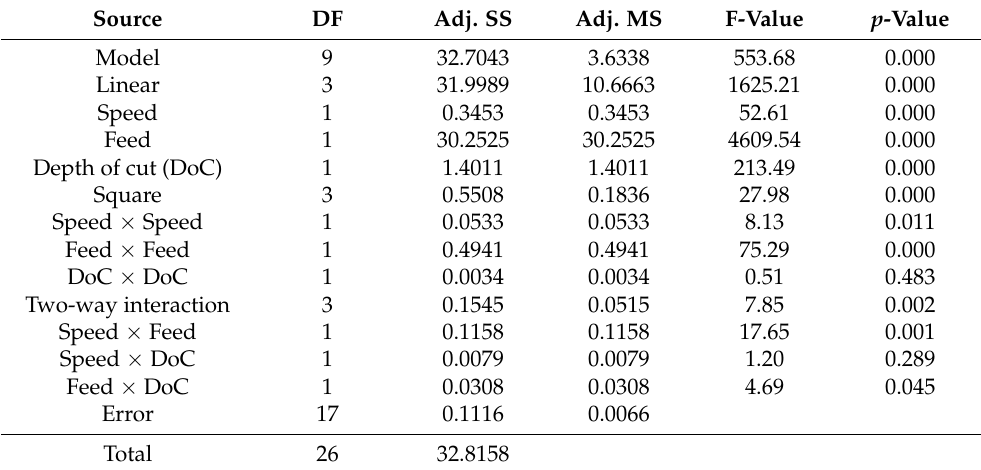
Table 6. ANOVA for surface roughness of the RZ5/8 wt.% TiB 2 composite using adjusted SS for